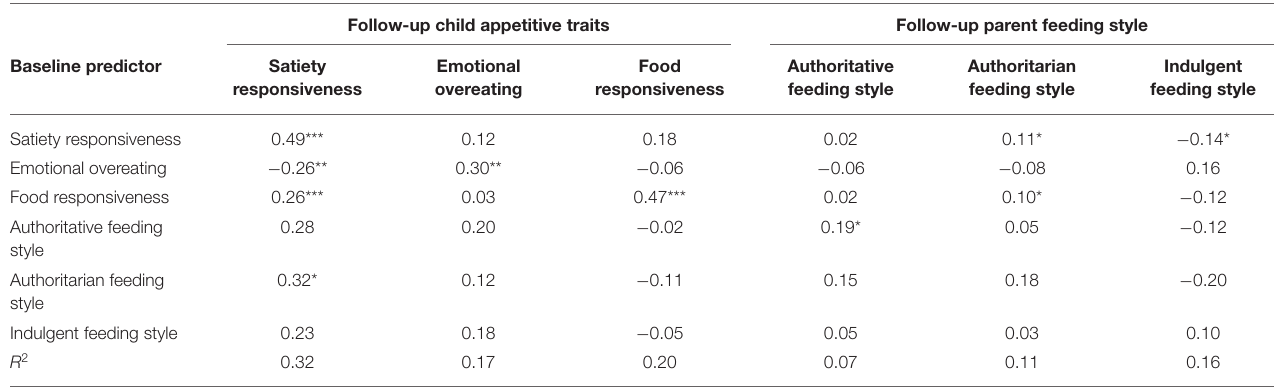
TABLE 2 | Results of cross-lag panel analyses predicting follow-up variables from baseline variables (unstandardized B weights).